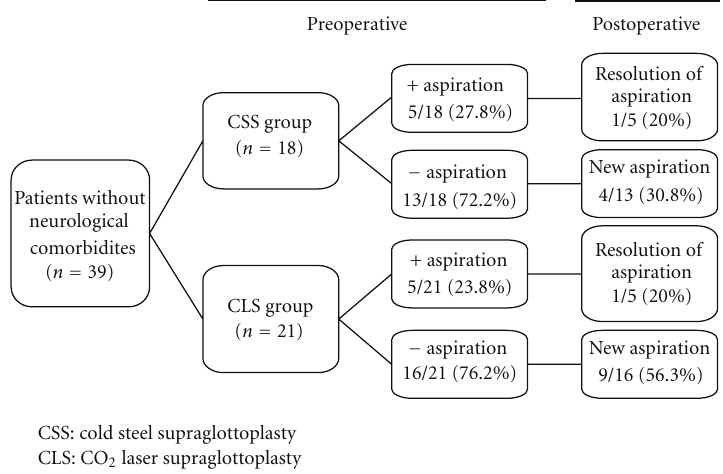
Figure 1: Aspiration in patients without neurological comorbidities.